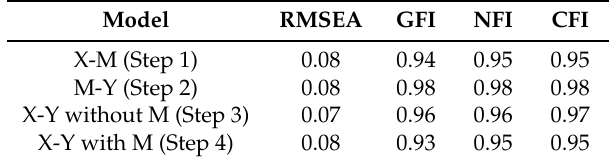
Table 4. The goodness-of-fit indices in the four models determining the mediating effect of PsyCap.